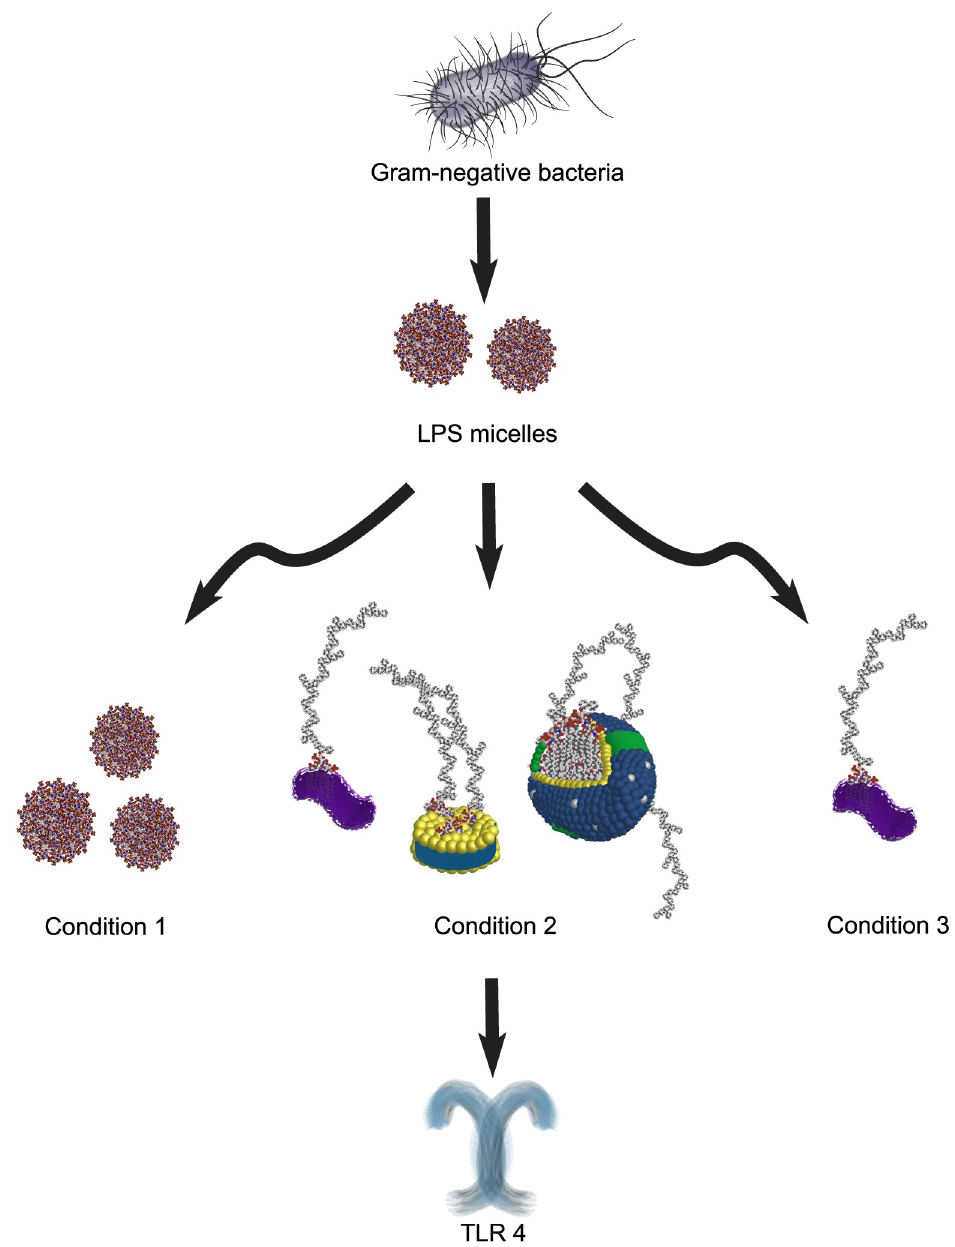
Fig 1. Schematic of the conditions of LPS presentation in media. Condition 1 is when LPS is presented to TLR4(+) cells in serum-free media (buffer), though below the CMC, LPS can also present as a monomer. Condition 2 demonstrates association of LPS with some of the common carrier proteins in serum; LBP, HDL, and LDL. Condition 3 shows presentation of LPS to cells with de-lipidated serum, when serum carrier proteins HDL and LDL are inactivated by de-lipidation, but LBP functionality